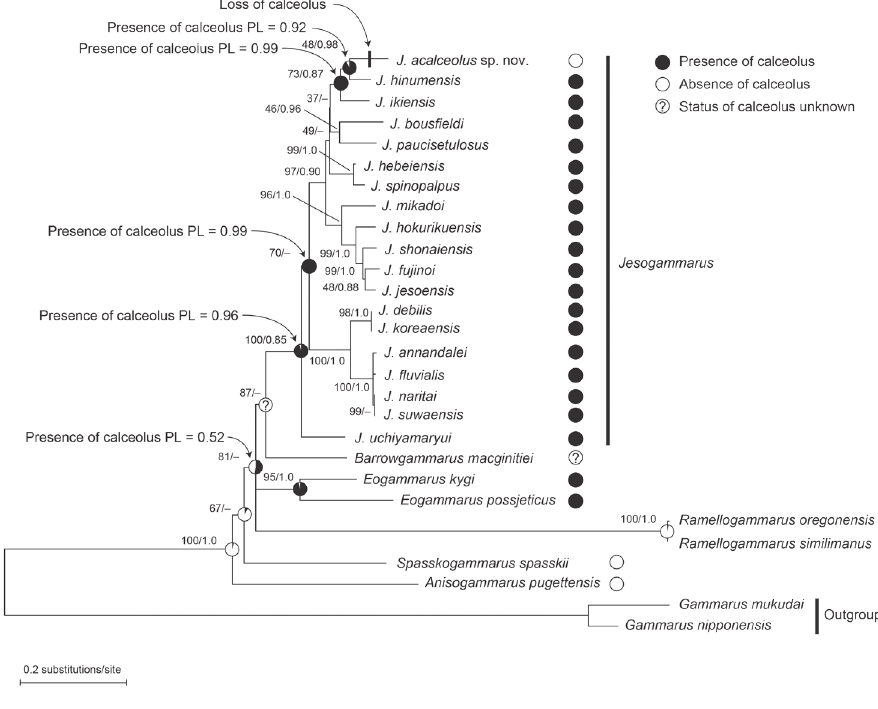
Figure 2. Maximum likelihood tree and ancestral state reconstructions for calceolus on male antenna 2. Filled circles at each species represent states of habitat; pie charts at internal nodes present proportional likelihoods of reconstruction. Key nodes are labelled with the proportional likelihood of the presence or absence of the calceolus on male antenna 2, which was reconstructed as most likely to be at that